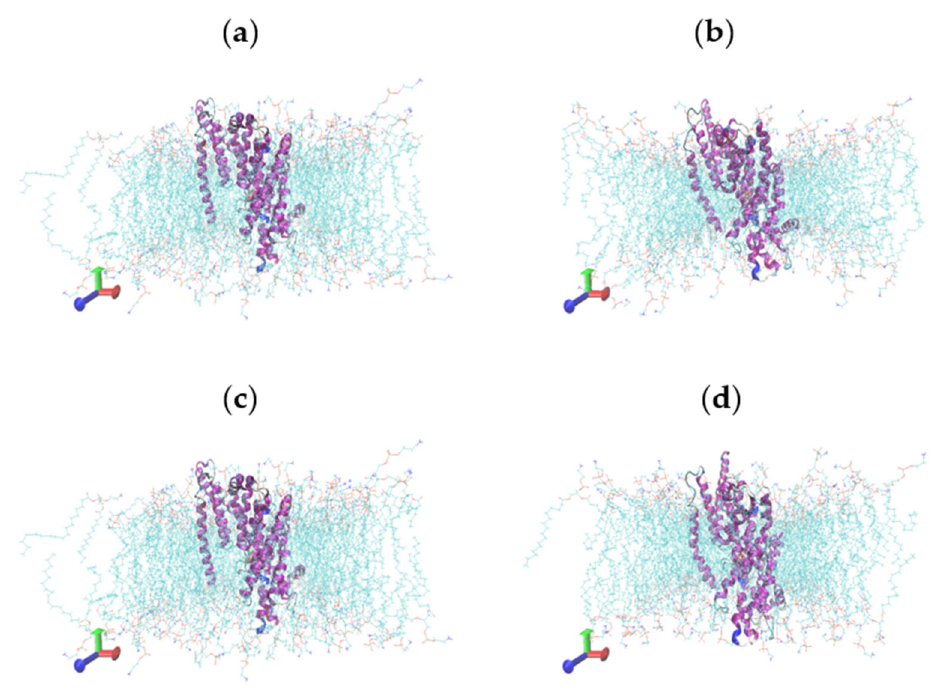
Figure 10. The binding conformations and molecular interaction of SoDIT-a-CIT system versus MD simulation course. ( a ) 0 ns, ( b ) 10 ns, ( c ) 20 ns, ( d ) 30 ns, SoDIT-a was in cartoon, membrane in line, a ligand in a circle.